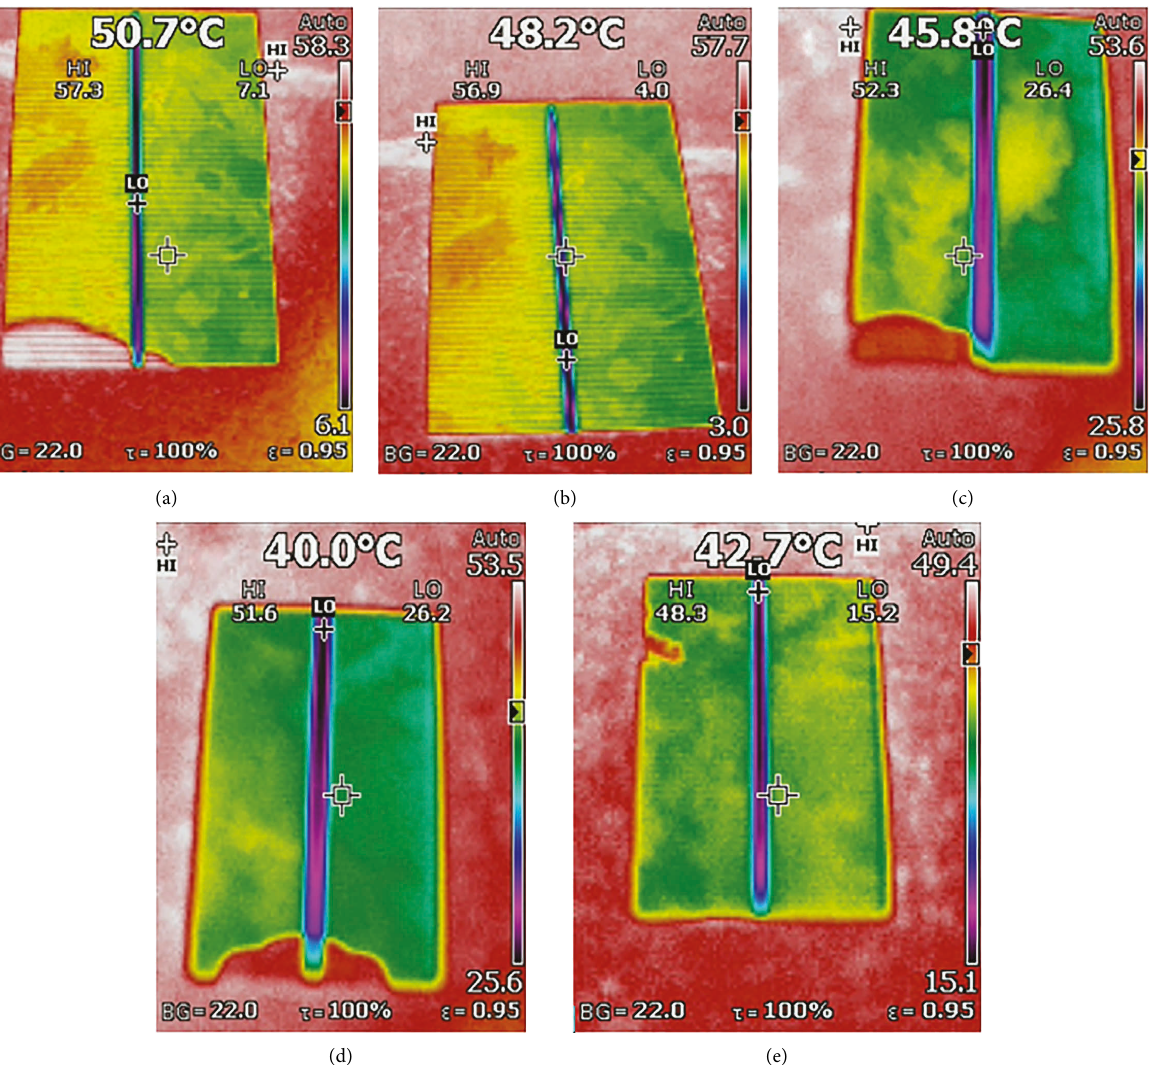
Figure 11: Thermal analysis under controlled source environment: (a) B-I (uncoated), (b) B-II (SiO (TiO 2 /SiO 2 ), and (e) B-V (SiO 2 /TiO 2 ).